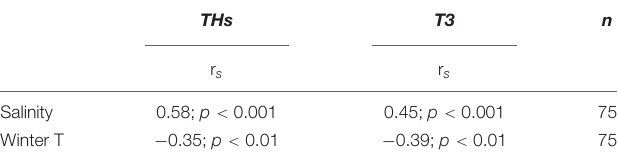
TABLE 2 | Spearman rank correlation coefficient (r s ) examining the relation between salinity, winter temperature (T) and concentration of thyroid hormones (THs and T3) in the ovarian tissue of the Baltic herring in 1990–2019. THs T3 n r s r s Salinity 0.58; p < 0.001 0.45; p < 0.001 75 Winter T − 0.35; p < 0.01 − 0.39; p < 0.01 75 n = number of females analyzed; p = risk level.